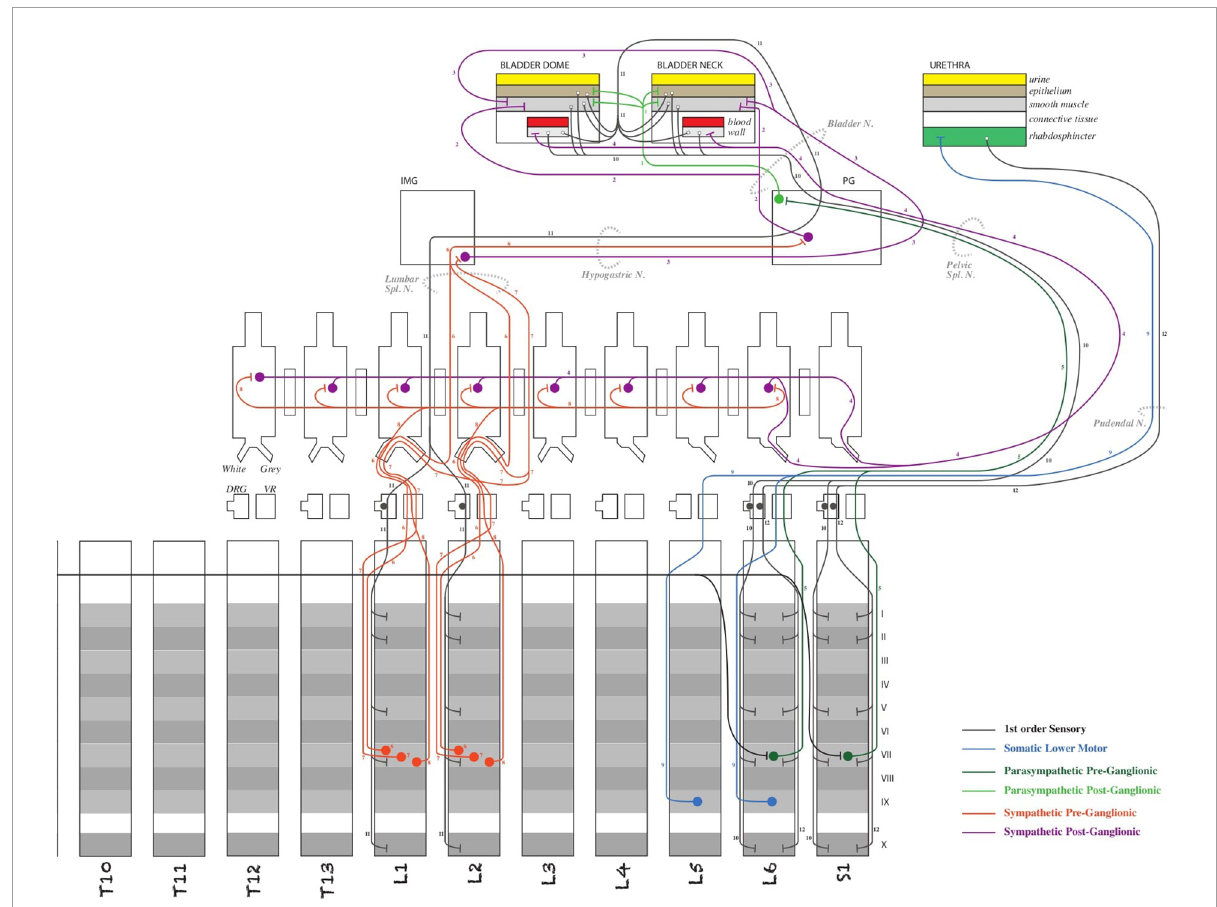
FIGURE5 Schematic diagram of the ApiNATOMY model of bladder innervation (Surles-Zeigler et al., 2021). The diagram illustrated major neural circuits involving the urinary bladder and urethra.